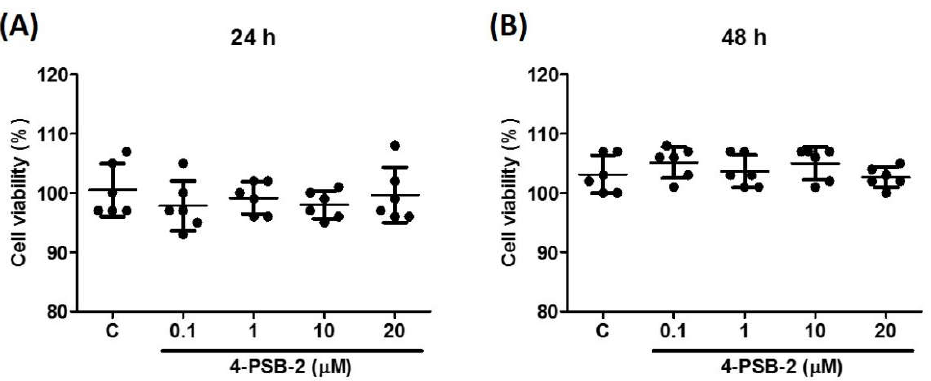
Figure 2. 4-PSB-2 had no cytotoxic effect in THP-1 cells. After treatment with medium alone ( C ) or 4-PSB-2, the cell viability of THP-1 cells was measured for 24 h ( A ) and 48 h ( B ). Data present the means ± SD of 3 independent